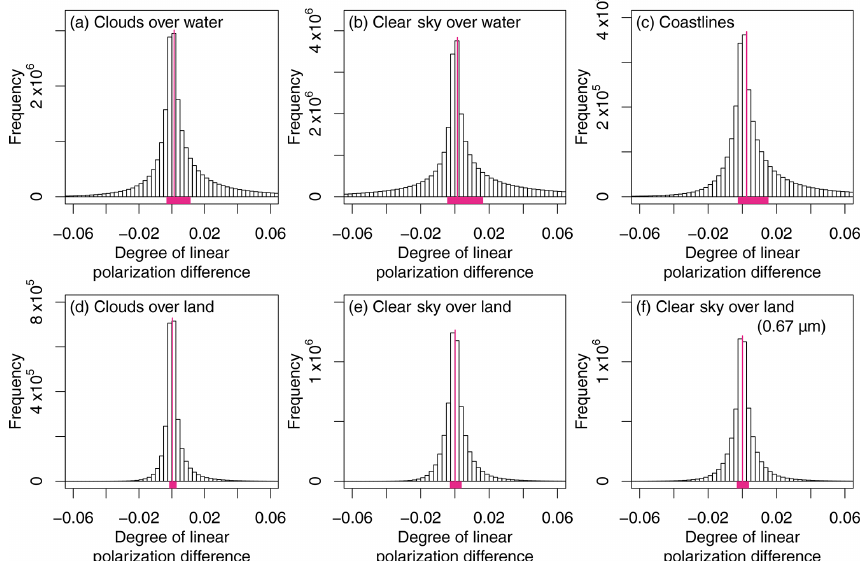
Figure 4. Histograms of proxy–reference differences in degree of linear polarization (DOLP) for (a) clouds over water, (b) clear sky over water, (c) coastlines, (d) clouds over land, (e) clear sky over land, and (f) clear sky over land at 0.674µm. Except for (f) , the wavelength is at 0.869µm. The vertical magenta line indicates the location of the median, and the magenta bar at the bottom indicates the interquartile